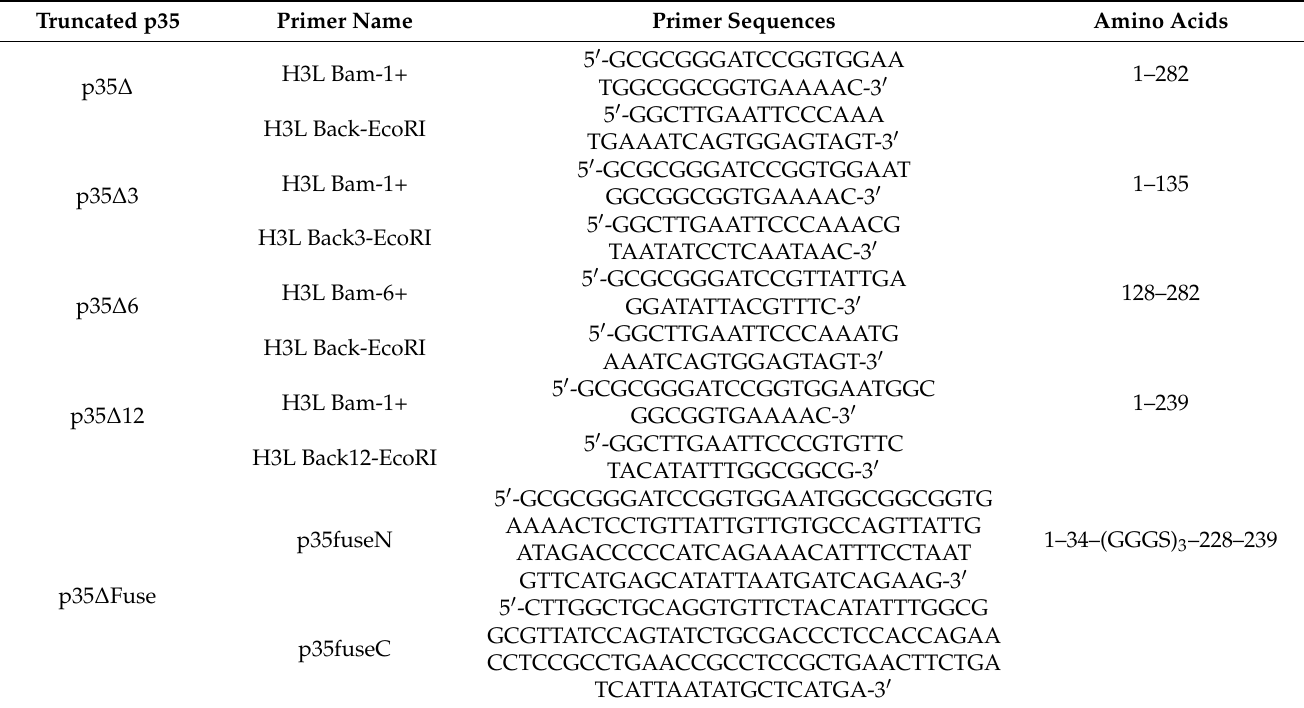
Table 1. Primers used for the development of recombinant p35 of